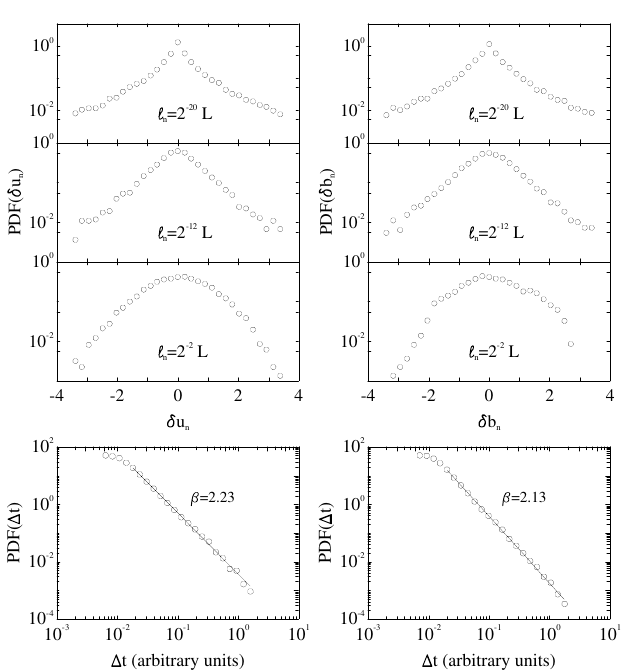
Figure 91: In the first three panels we report PDFs of both velocity (left column) and magnetic (right column) shell variables, at three different shells ℓ 𝑛 . The bottom panels refer to probability distribution functions of waiting times between intermittent structures at the shell 𝑛 = 12 for the corresponding velocity and magnetic variables.